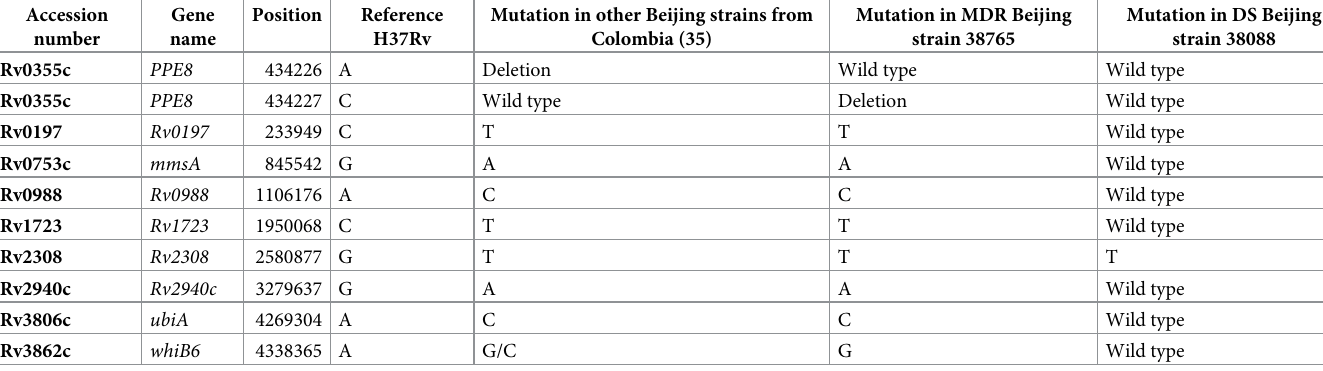
Table 4. Comparison of the previously reported SNPs in Beijing-like strains from Colombia and the Beijing strains of this